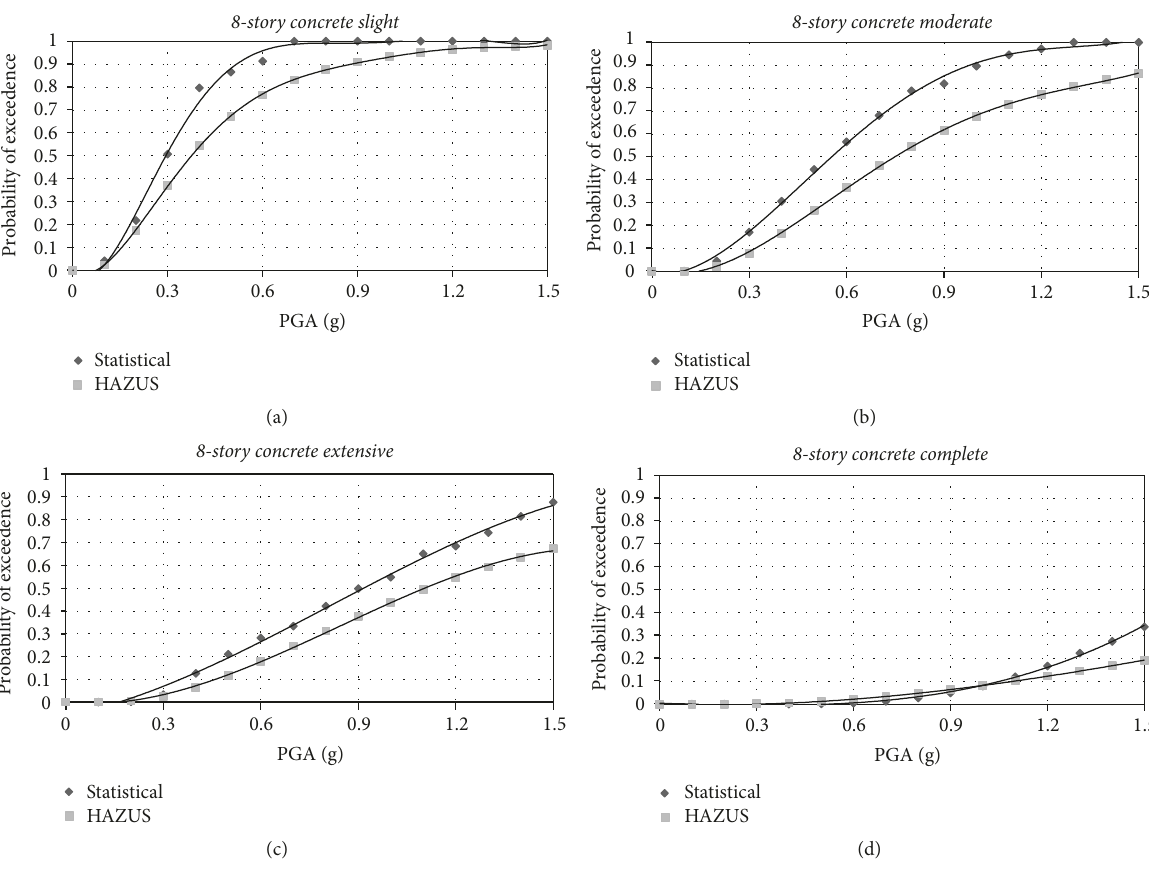
Figure 19: The fragility curves for the 8-story RC frame